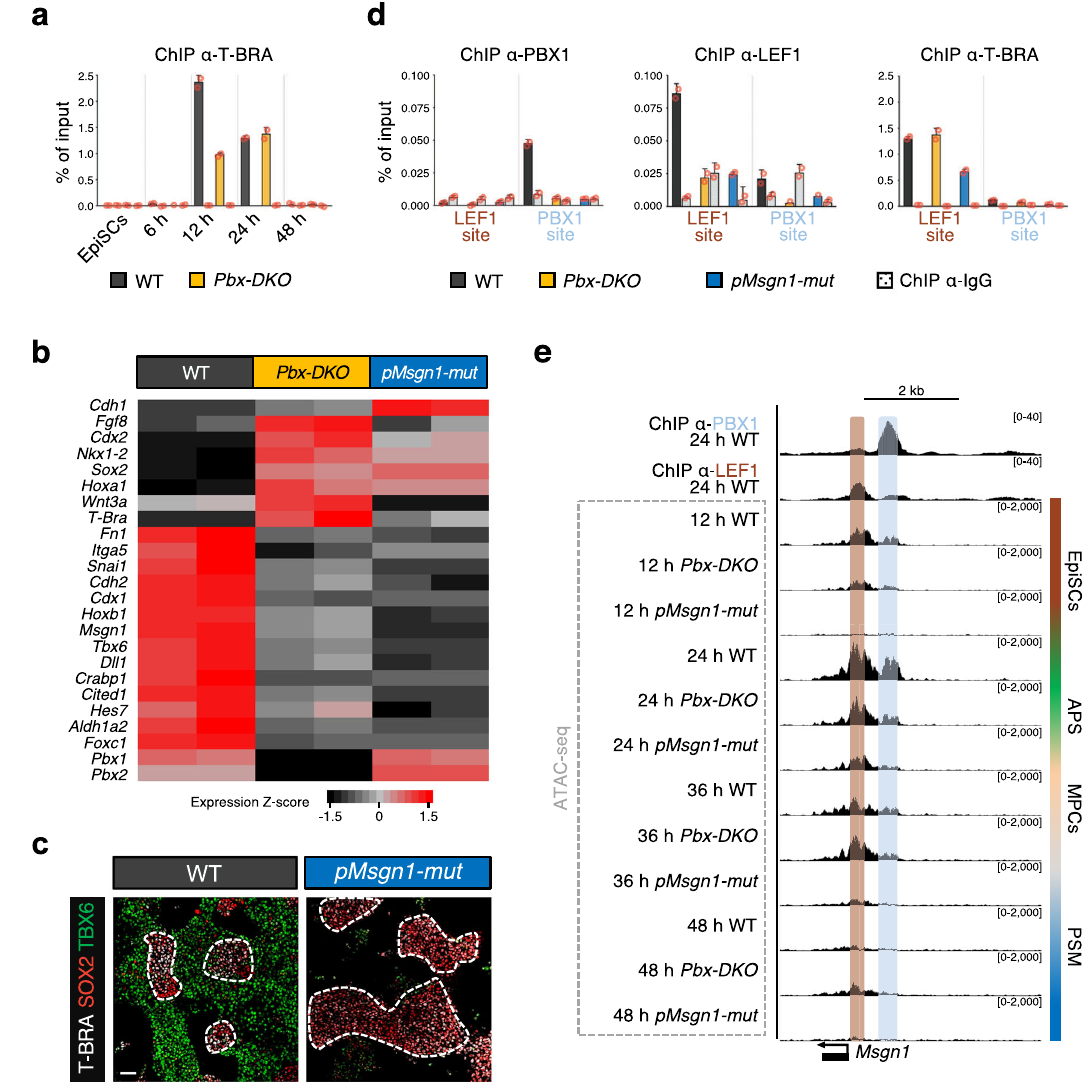
Fig. 7 Combined pioneering activity of T-BRA and TALE proteins remodels the chromatin, making it accessible at Msgn1 regulatory regions, thereby directing WNT transcriptional response. a ChIP-qPCR analysis showing speci fi c recruitment of T-BRA to the LEF1-binding site of the Msgn1 regulatory region at 12 and 24 h. T-BRA binding is maintained in Pbx-DKO cells (yellow). b Heatmap displaying relative expression of selected differentially regulated genes in WT (black), Pbx-DKO (yellow) and pMsgn1-mut cells (blue) at 24 h (RNA-seq, P ≤ 0.05, fold-change ≥ 1.5). pMsgn1-mut allele carries point mutations in the PBX/HOX-1-binding site. Representative PSM and NMP markers are indicated. n = 2 biological replicates. Signi fi cance was assessed by DESeq2 on the basis of two-sided Wald test with Benjamini – Hochberg adjusted P- values. c Representative immuno fl uorescence staining for T-BRA (white), SOX2 (red) and TBX6 (green) at 48 h of differentiation reveals expansion of NMPs (T-BRA pos ;SOX2 pos , dashed white lines) and reduction of PSM (TBX6 pos ) in pMsgn1-mut cells. Scale bar: 50 µ m. d ChIP-qPCR analysis on the Msgn1 promoter displays PBX1 recruitment at the PBX/HOX-1-binding site in WT (black), but not in Pbx-DKO (yellow) nor in pMsgn1-mut cells (blue). Similarly, ChIP-qPCR analyses with LEF1 and T-BRA antibodies highlight speci fi c binding of LEF1 and T-BRA to the LEF1-binding region in WT cells. While T-BRA is recruited to the Msgn1 promoter in Pbx-DKO and pMsgn1-mut cells, LEF1 binding is lost in both. Data are mean ± s.e.m. ( n = 2 biological replicates) in a and d . e Chromatin accessibility analysis (ATAC-seq) of the Msgn1 locus in WT, Pbx-DKO and pMsgn1-mut cells along PSM differentiation displays speci fi c open regions overlapping with the PBX (light blue) and LEF1-binding sites (brown) in WT cells at 12 and 24 h. In Pbx-DKO cells, accessibility is strongly reduced at the PBX/HOX-1-binding region. Additionally, accessibility of the Msgn1 locus is severely impaired in both LEF1 and PBX/HOX-1-binding regions in pMsgn1-mut cells, con fi rming the role of the PBX complexes as modulators of chromatin accessibility on WNT-responsive elements. Threshold of vertical viewing range of data based on RPKM values is speci fi then overnight at 4 °C. Following incubation with CAS-Block containing 1µg/ml DAPI for 1 h at RT, embryos were washed three times with PBS + 0.5% (v/v) Triton X-100 for 15min at RT and dehydrated in ascending series to 100% methanol. To reduce light scattering, optical clearing was performed by submer- ging the stained embryos in a 1:2 (v/v) solution of benzyl alcohol:benzyl benzoate (BABB). Images were acquired using a Leica TCS SP8 confocal microscope. Image processing and 3D reconstruction were performed using the Imaris TM software (v9.3.0). In Figs. 2c, d and 3i and Supplementary Fig. 2b, only cells expressing high levels of either T-BRA, SOX2 or TBX6 were included in the scoring.